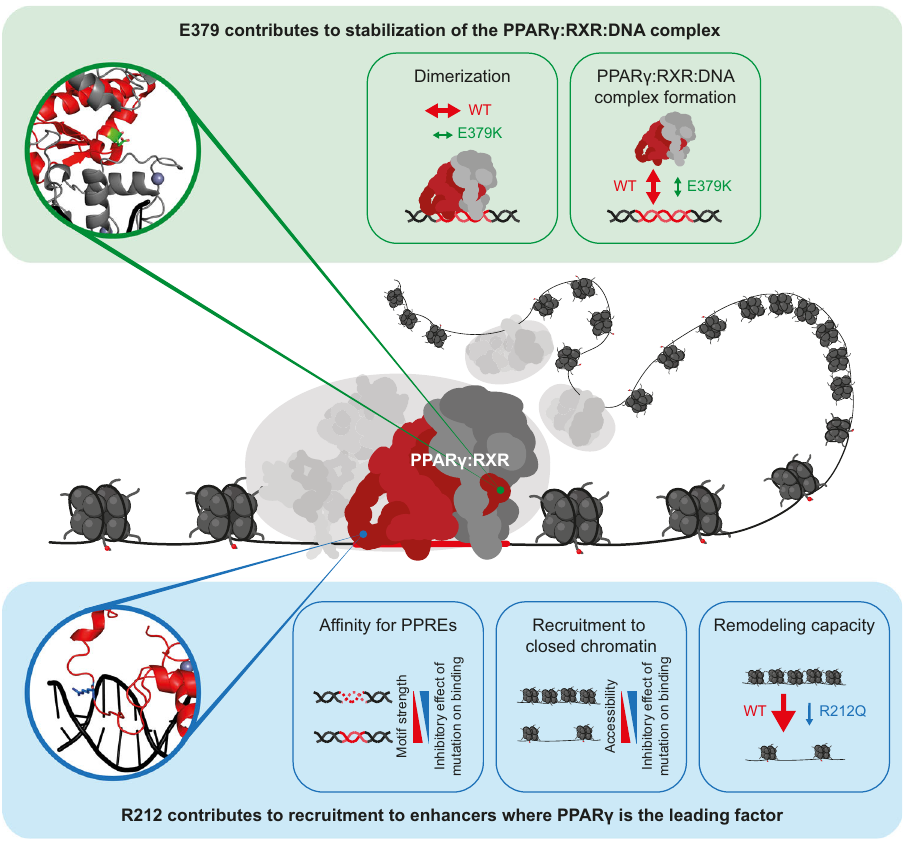
Fig.10|ModelillustratinghowE379KandR212Qlipodystrophymutantsreveal important interaction interfaces in the PPAR γ :RXR:DNA complex. Central panel: PPAR γ :RXR:DNA ternary complex with the respective positions of E379 and